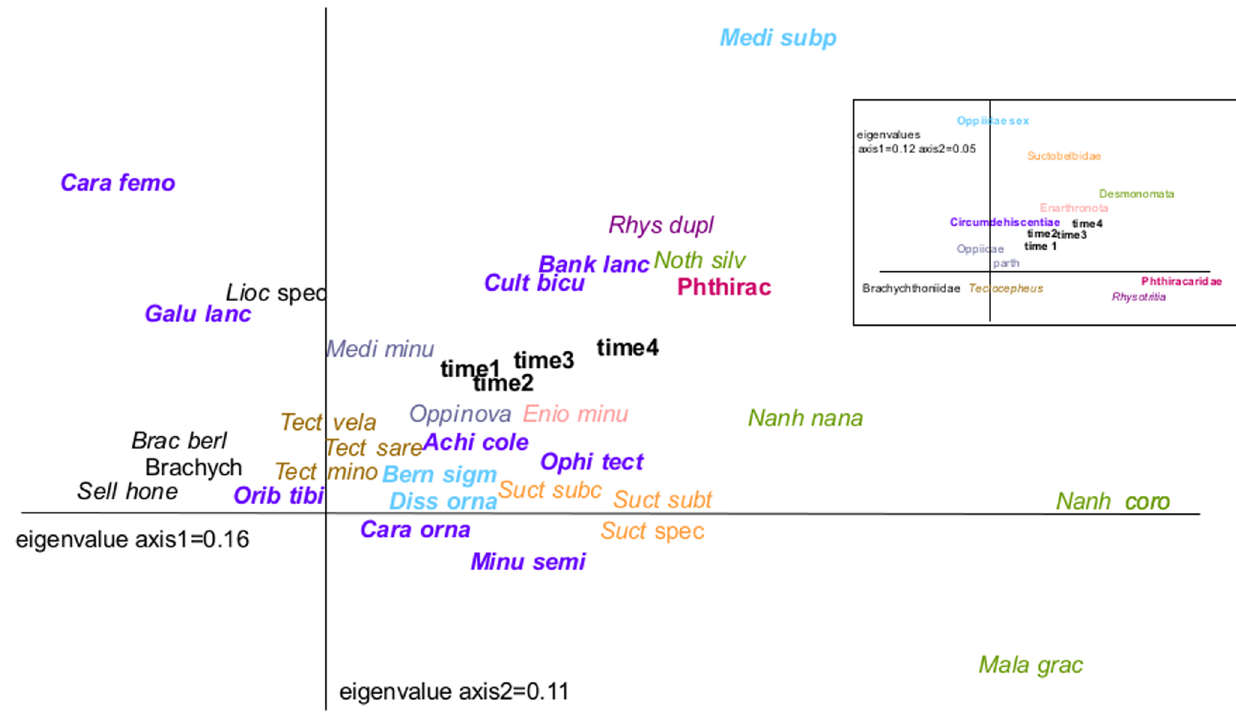
Figure 4. Response of oribatid mite species. Detrended correspondence analysis of oribatid mite species and subgroups (given in different colours; see small graph in figure) with sampling time included as supplementary variable not affecting the ordination (time 1=2 weeks, time 2=10 weeks, time 3=20 weeks, time 4=44 weeks). Bold names indicate sexual reproduction. Ache cole = Achipteria coleoptrata , Bank lanc = Banksinoma lanceata, Bern sigm = Berniella sigma , Brac berl = Brachychthonius berlesei , Brachych = Brachychthoniidae, Cara femo = Carabodes femoralis , Cara orna = Carabodes ornatus , Cult bicu = Cultroribula bicultrata , Diss orna = Disshorina ornata, Enio minu = Eniochthonius minutissimus, Galu lanc = Galumna lanceata , Lioc spec = Liochthonius sp., Mala grac = Malaconothrus gracilis, Medi subp = Medioppia subpectinata, Medi minu = Microppia minus, Minu semi = Minunthozetes semirufus , Nanh coro = Nanhermannia coronata, Nanh nana = Nanhermannia nana, Noth silv = Nothrus silvestris , Ophi tect = Ophidiotrichus tectus, Oppi nova = Oppiella nova, Orib tibi = Oribatula tibialis , Phthirac = Phthiracaridae, Rhys dupli = Rhysotritia duplicata , Sell hone = Sellnickochthonius honestus , Suct spec = Suctobelbella sp., Suct subc = Suctobelbella subcornigera, Suct subt = Suctobelbella subtrigona, Tect mino = Tectocepheus minor